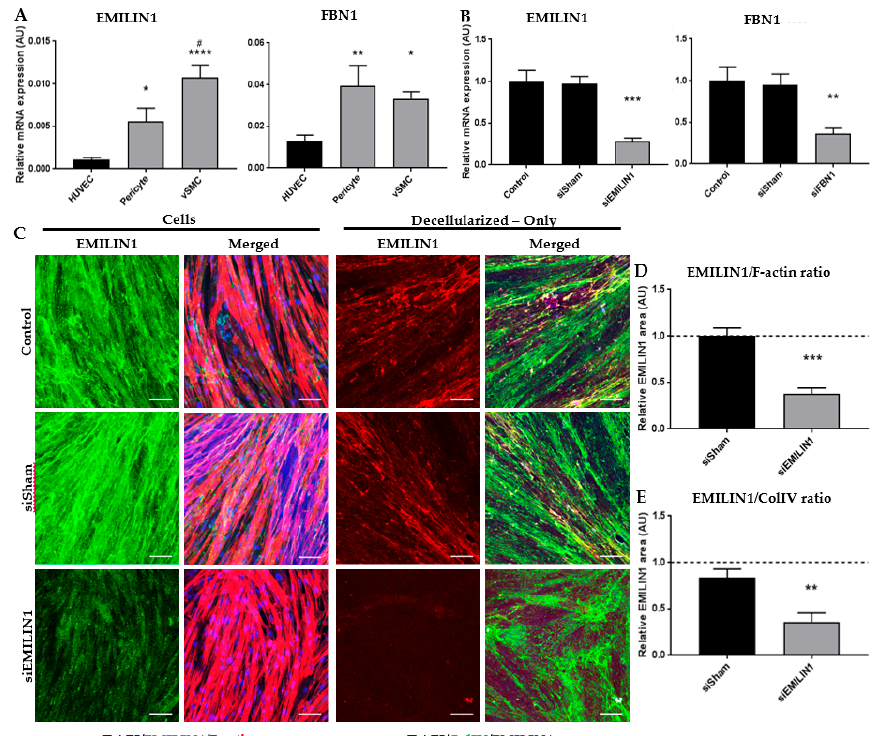
Figure 4. ( A ) qPCR analysis of EMILIN1 and FBN1 in different cell types of the vasculature, human umbilical vein endothelial cells (HUVECs; as endothelium source), pericytes and vascular smooth muscle cells (vSMC; hereafter referred as SMC). Data are shown as mean ± SEM corrected for beta-actin (housekeeping gene). N ≤ 10, * p < 0.05, ** p < 0.01, **** p < 0.0001 compared to HUVECs, # p < 0.05 compared to pericytes (One-way analysis of variance (ANOVA), Tukey’s post hoc test). ( B ) qPCR validation of EMILIN1 and FBN1 knockdown in SMC 6 days after siRNA transfection. Data are shown as mean ± SEM, N = 7–9 for EMILIN1 and FBN1 , respectively. ** p < 0.01, *** p < 0.001 compared to siSham (Student’s t -test). ( C ) Representative z-stacks of EMILIN1 on SMC cultured for 6 days after siRNA transfection and after decellularization. Scale bar represents 100 µm. ( D ) Quantification of EMILIN1 signal-corrected for the amount of F-actin in siRNA-treated SMC. Data are shown as mean ± SEM, N = 5. ( E ) Quantification of EMILIN1 signal-corrected for the amount of collagen type IV present on SMC-derived ECM coverslips. Data are shown as mean ± SEM, N = 7, ** p < 0,01, *** p < 0,0001 (Student’s t -test). Non-treated SMC are set to one (dotted lines).